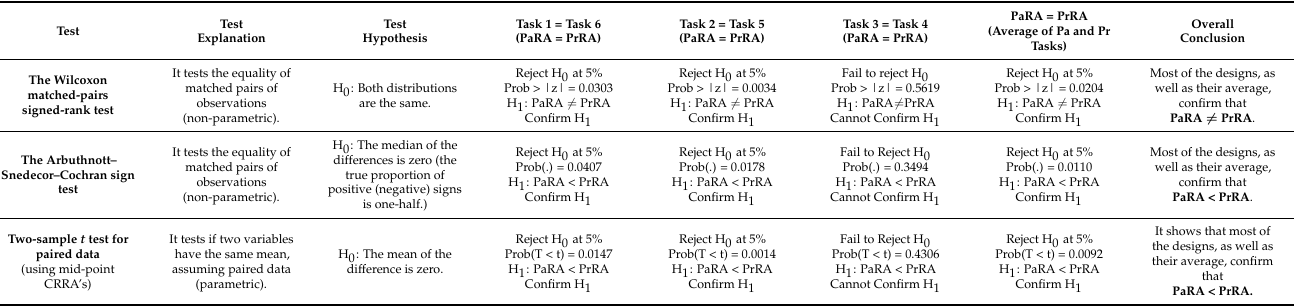
Table 2. Summary of the major results of the three main statistical tests concerning the equivalence of PaRA and